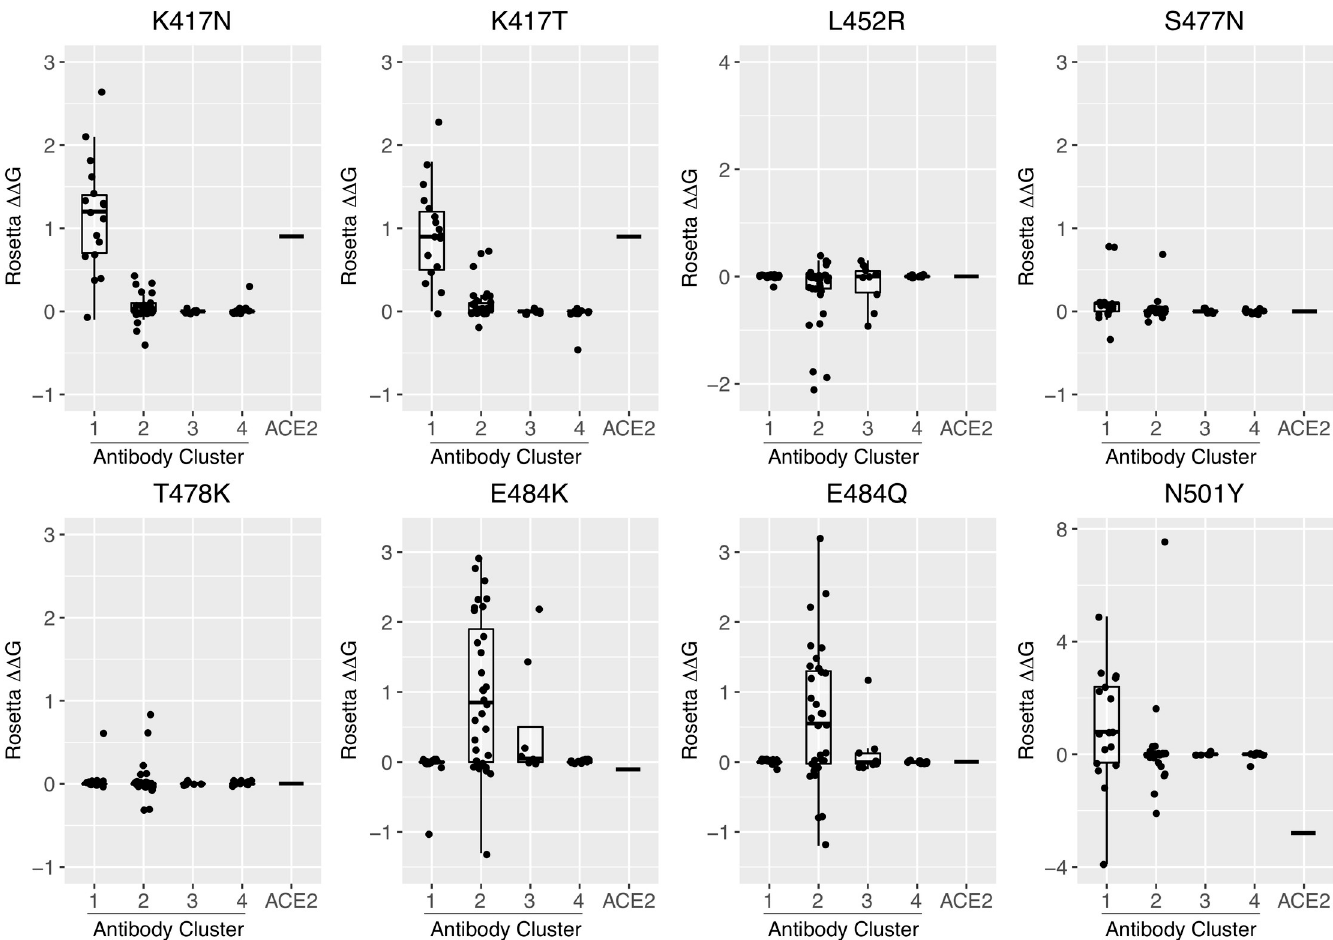
Fig 7. Profiling antibody and receptor binding effects of RBD point substitutions from circulating SARS-CoV-2 variants. Computational mutagenesis in Rosetta [26] was used to predict binding affinity effects ( ΔΔ Gs) of RBD variant substitutions K417N, K417T, L452R, S477N, T478K, E484K, E484Q, and N501Y for 70 antibodies that target the RBD, as well as the ACE2 receptor. ΔΔ G values are shown as boxplots grouped by antibody clusters, with all antibody ΔΔ G values shown as points, and the ACE2 ΔΔ G value represented as a horizontal bar in each boxplot. ΔΔ G values are in Rosetta Energy Units (REU), which are comparable to energies in